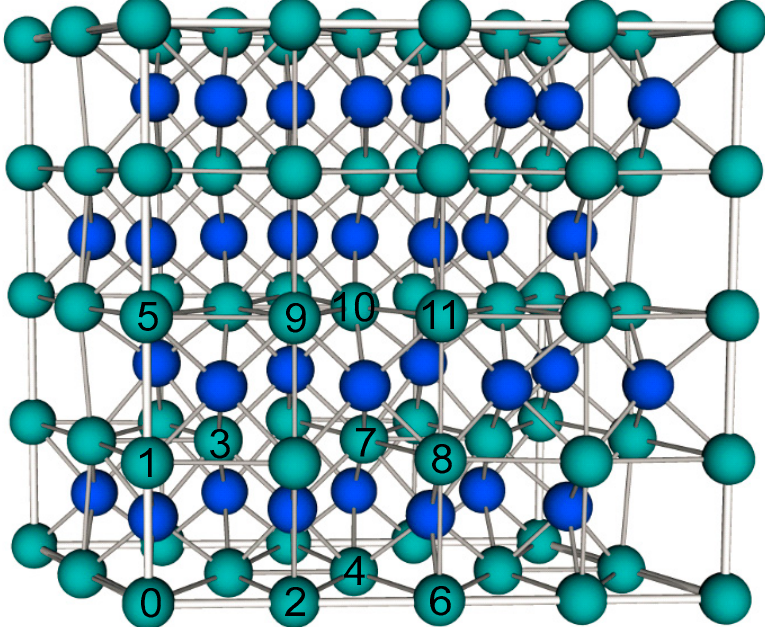
Figure 4. A 2 × 1 × 2 supercell structure of δ -MoN. With respect to one Mn atom (labeled as 0), we select eleven nonequivalent positions for the other Mn atom (as numbered from 1 to 11) based on the symmetry of the supercell. The green and blue balls denote the Mo and N atoms, respectively. After geometry optimization, we calculated the formation energies for all the eleven nonequivalent configurations based on Equation (1), and the results are presented in the eighth column of Table 2. The formation energy for the single-doped system, in which is one single Mn atom doped at 0 Mo lattice site, is also calculated for comparison. It is observed from Table 2 that the formation energies of these double-doped systems vary from − 3.06 to − 3.48 eV, which is much lower than that of the single-doped system ( − 1.73 eV). This indicates that the formation energy of Mn decreases with its doping concentration, and it is highly favorable to form Mn substitution in δ